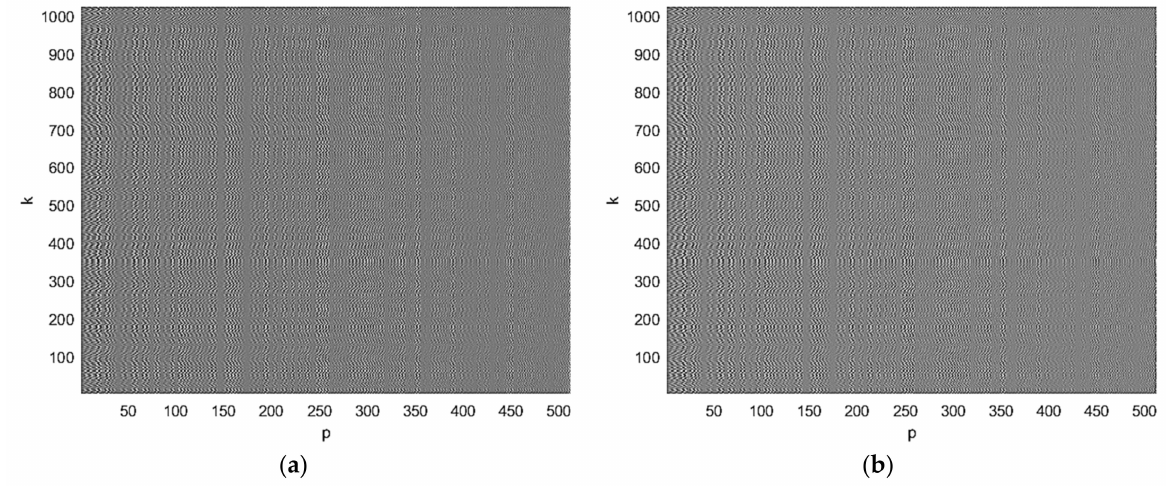
Figure 3. Complex BFISAR signal presented by ( a ) real and ( b ) imaginary parts.